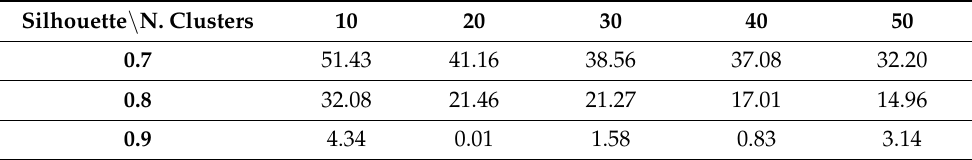
Table 11. Clustering performance in terms of silhouettes using the reduced dataset with PCA applied to normalized data. Silhouette \ N. Clusters